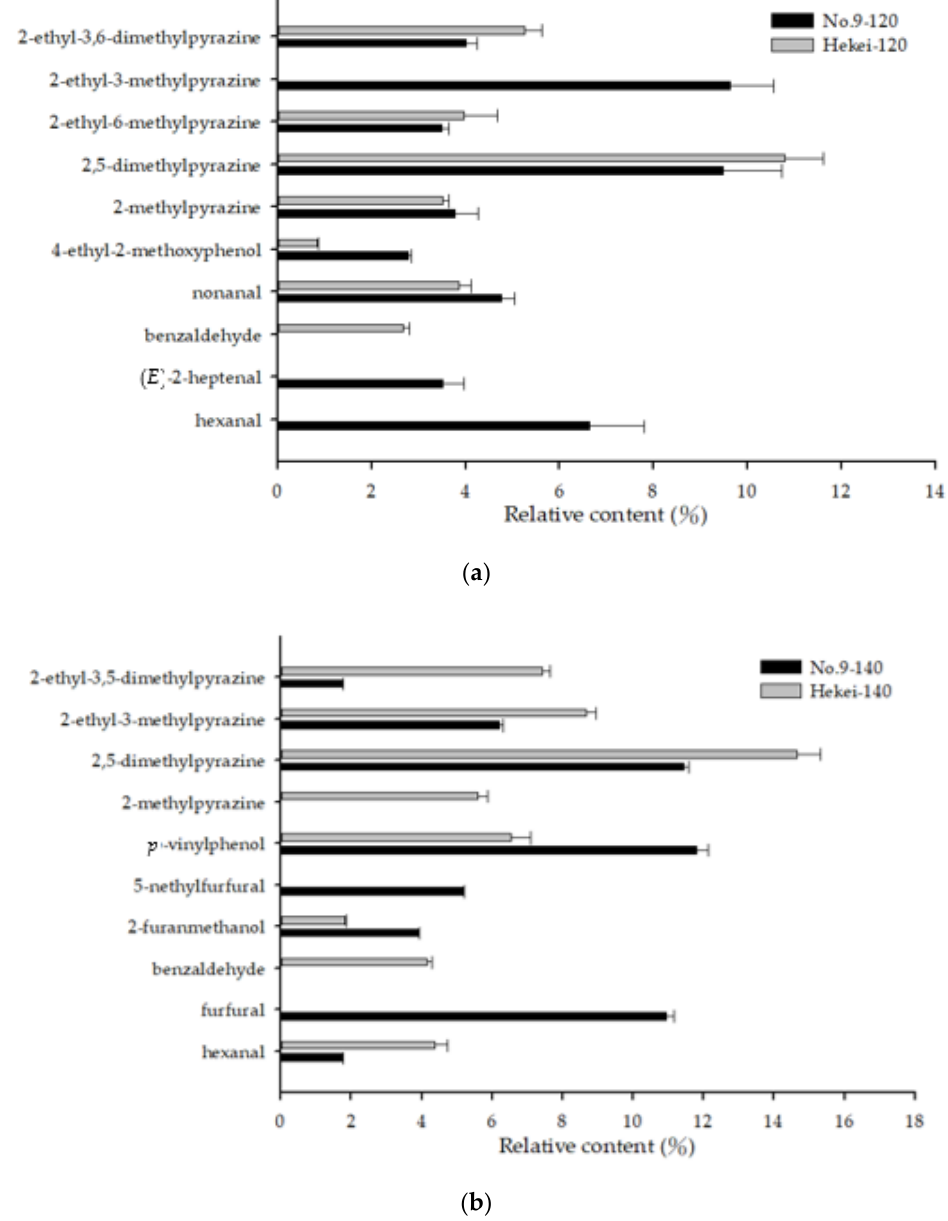
Figure 6. The main volatile compounds of different varieties of peanut oil: ( a ) peanut oil roasted at 120 °C; ( b ) peanut oil roasted at 140 °C.